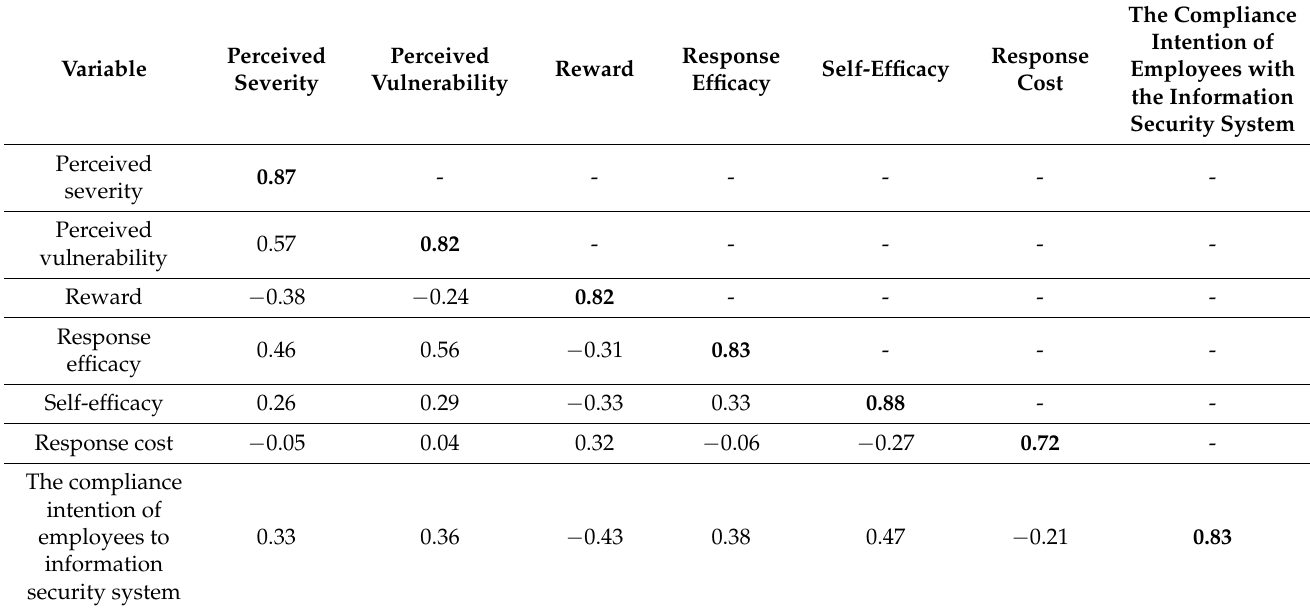
Table 3. Discriminant validity test